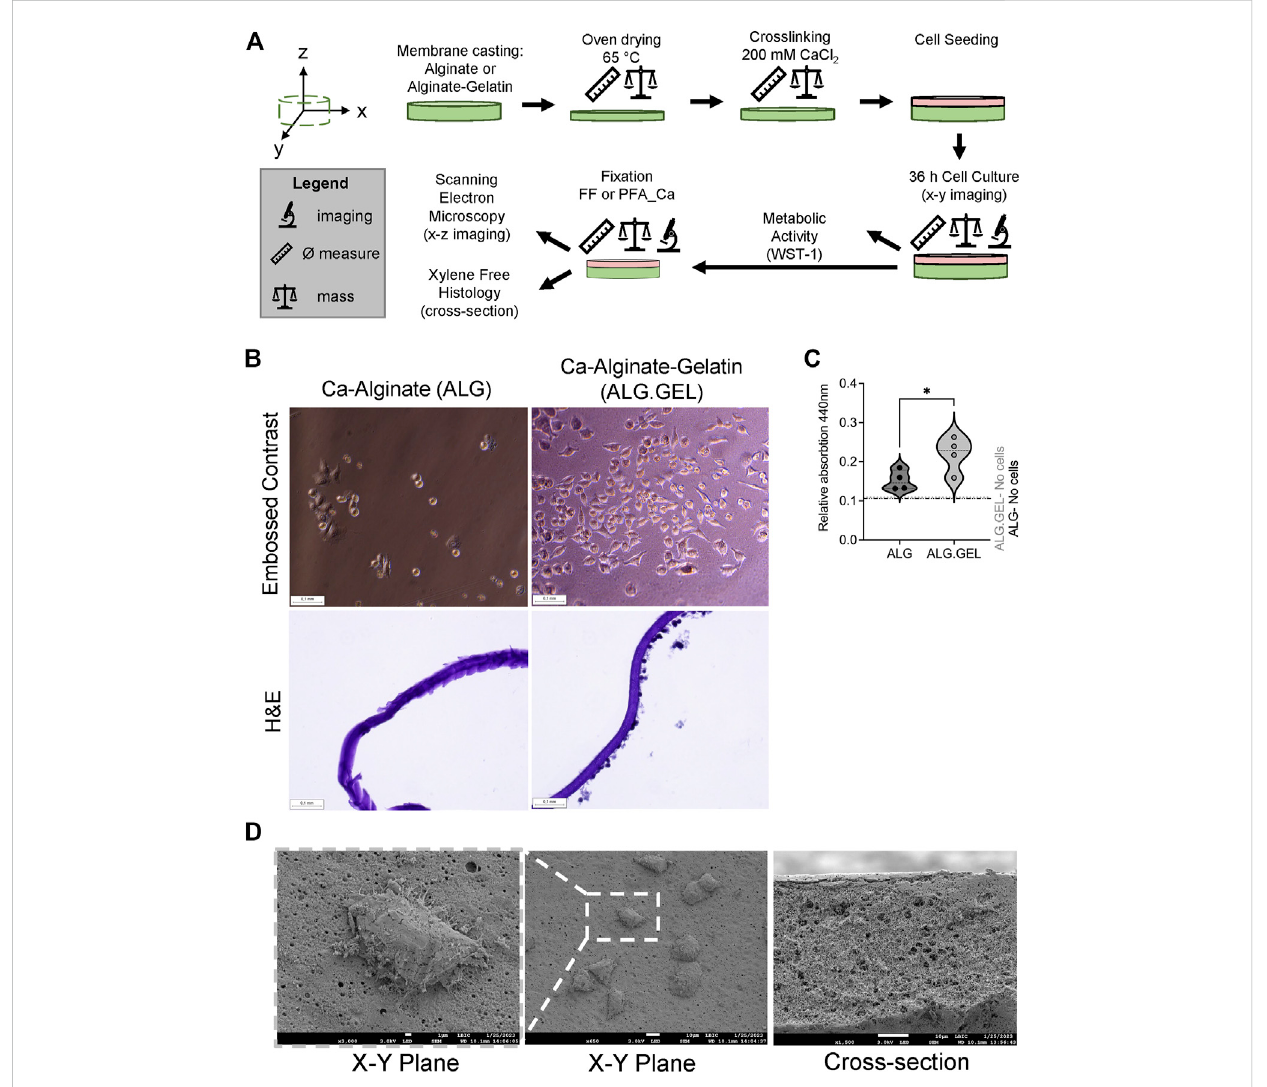
FIGURE 5 Fabrication and characterization of epithelial cells grown on alginate and hybrid alginate-gelatin membranes for histological cross section and scanning electron microscopy evaluation. (A) Schematic overview of the manufacturing process as well as data collection. (B) Embossed contrast imaging (representing x-y) imaging of cells grown on alginate versus hybrid alginate-gelatin membranes. H&E cross sectional (x – z) plane imaging showing monolayers of epithelial cells growing on only one side of a membrane. Both membranes were processed using FF fi xation. (C) Increased metabolic activity as assessed by WST-1 assay. Individual dots are technical replicates (n = 4) from the same manufacturing and cell seeding experiment. Representative of 3 independent experiments (N = 3). Calcium alginate and hybrid calcium alginate-gelatin membranes without cells but cultured under identicalconditionsserveascontrols.AllWST-1valuesareabovebackgroundlevels.* p -value < 0.05isconsideredstatisticallysigni fi cant.Non-parametric, Mann-Whitney t -test. Central tendency data is shown with a darker dashed line to indicate the median while lighter dashed lines indicate quartiles. (D) SEM micrographs of the apical and cross sectional surface of a hybrid alginate-gelatin membrane fi xed using FF and chemically dried with HMDS. Retention of fi ne structures, such as individual lamellipodia are still visible, demonstrating cell-biomaterial interactions. Cross sectional view of hybrid alginate-gelatin membrane demonstrating retention of porous structure during preparation from fi xed FF samples. Schematic in Figure 5A made using Microsoft